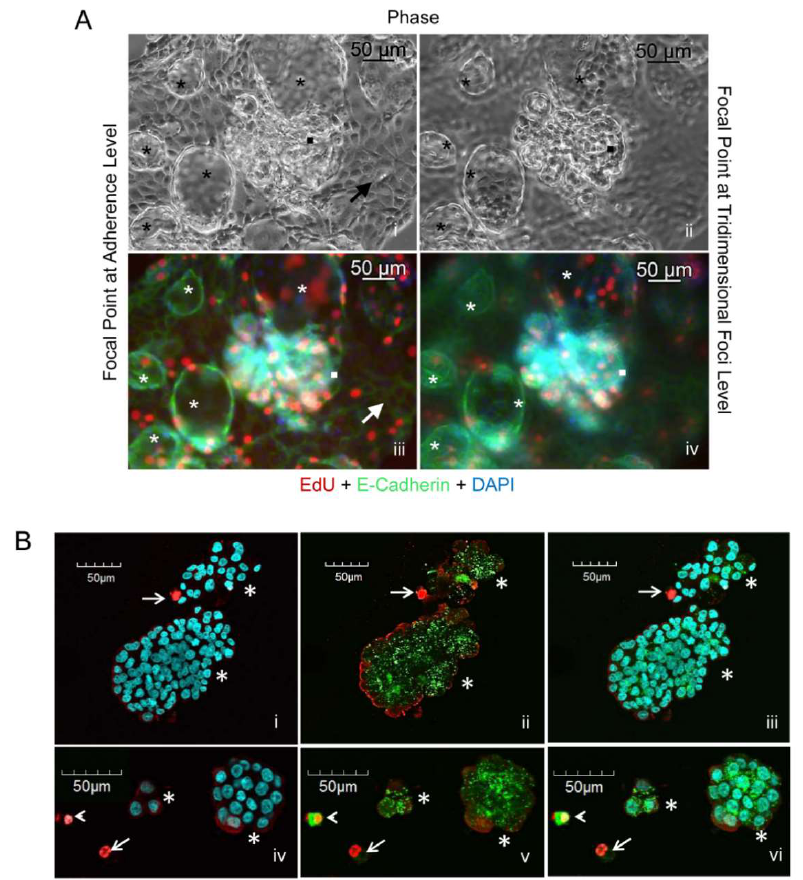
Figure 2. ( A ) Phase contrast imaging at focal [i] and 3D planes [ii] of PEO6 cells displaying a cellular monolayer ( arrow ), 3D irregular multicellular structures ( squares ), and spheroidal multicellular structures ( asterisks ). EdU incorporation (red fluorescence) and E-cadherin expression (green fluorescence) are shown at the focal plane [iii] and at the 3D plane [iv]. Blue, DAPI, depicting nuclei. ( B ) Live / dead ® viability / cytotoxicity assay of PEO6 cells arranged as multicellular structures as stained with DAPI [i, iv], calcein AM and EthD-1 [ii, v], and their overlay [iii, vi]. Asterisks denote multicellular structures mostly alive as assessed by their green calcein AM staining. Arrowheads denote dying cells (yellow), whereas arrows identify dead cells